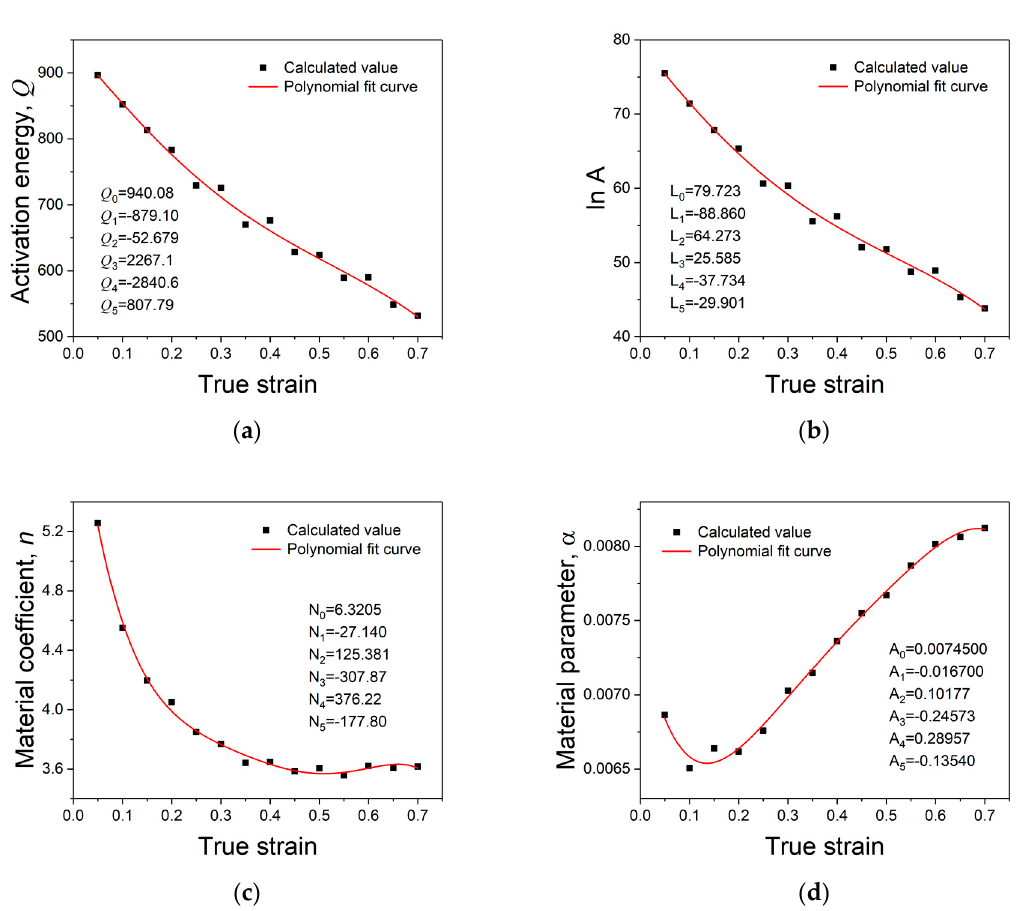
Figure 7. Relationships between ( a ) Q ; ( b ) ln A ; ( c ) n ; ( d ) α ; and true strain in polynomial fit of the PM/Wrought dual superalloy. Table 1. Polynomial fit results of Q , ln A , n , and α of the PM/Wrought dual superalloy.